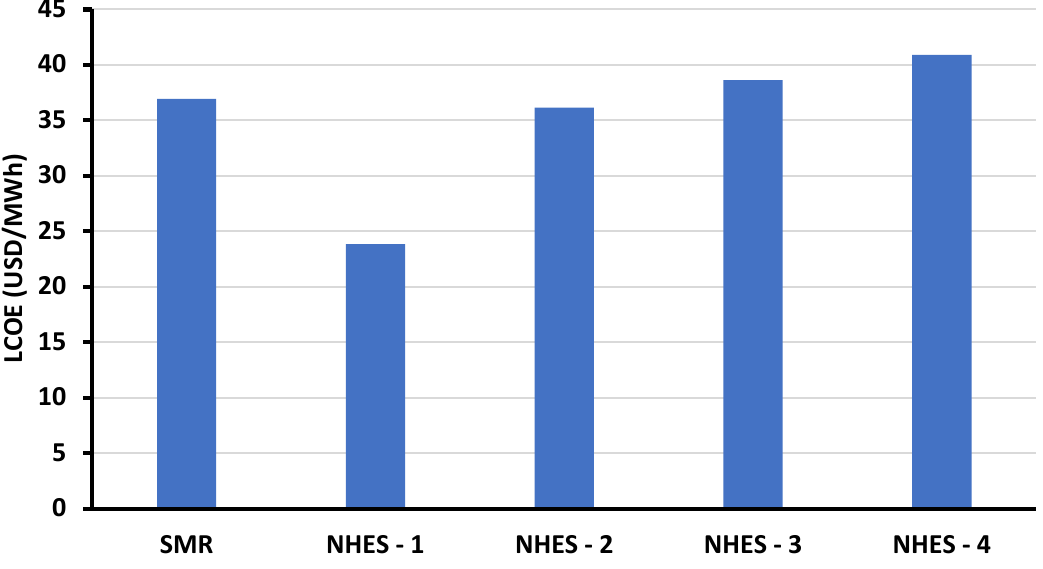
Figure 12. LCOE for SMR and different SMR-ChHP output scenarios .